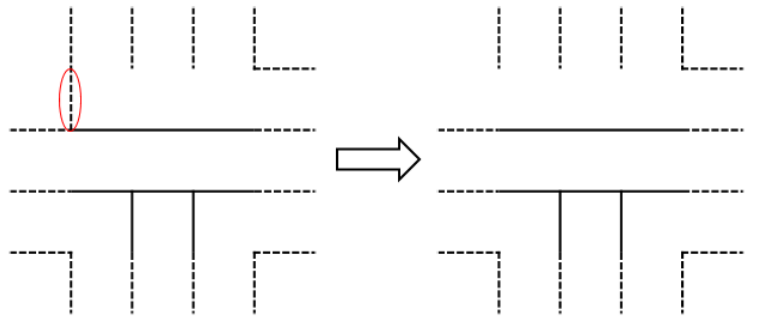
Figure 4 . The non-trivial centers of gauge (cid:12)elds with Coulomb gauge. The (cid:12)gures correspond to square regions of size n = 3. In the above two (cid:12)gures, we have done the gauge (cid:12)xing and all the operators on the links are physical. Links with solid lines mean both the corresponding operators ^ A and (cid:25) belong to the algebra and links with dashed lines mean the corresponding operator ^ A or (cid:25) does not belong to the algebra. Without loss of generality, let us assume operators ^ A to be on the dashed links, not (cid:25) . In the left (cid:12)gure, the operator ^ A on the dashed link in the red ellipse does not commute with (cid:25) on some dashed links. In the right (cid:12)gure, we remove that dashed link and all operators on dashed links form an ^ A center. We denote such an algebra as A ^ A . When the dashed links correspond to operators (cid:25) , not ^ A , we get the algebra of (cid:25) center. we denote it as A (cid:25) . a choice, all the operators associated to the boundary links commute with the rest of